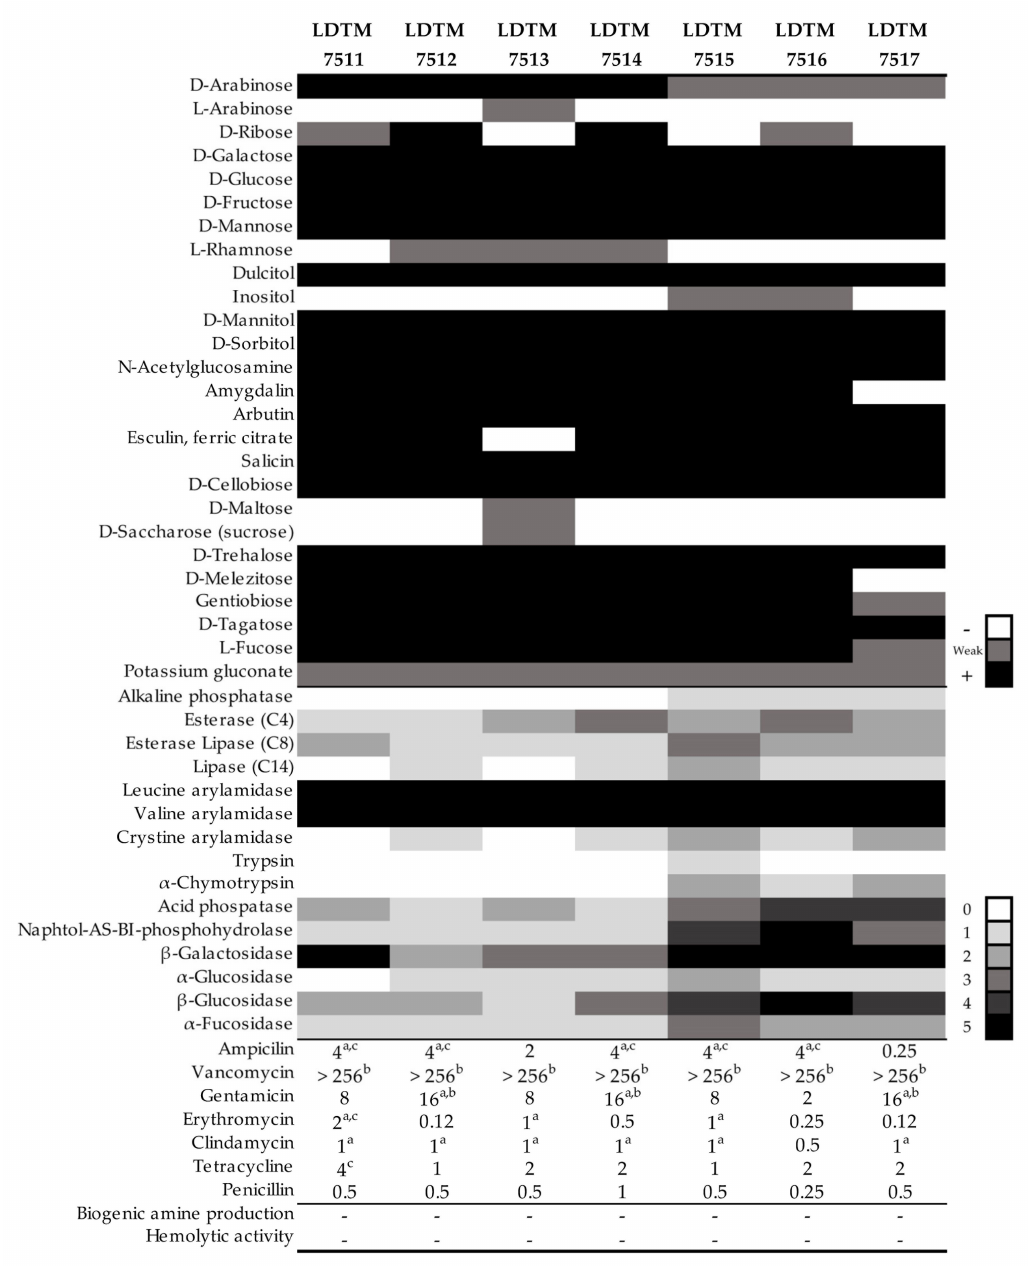
Figure 1. Fermentative / enzymatic profiles and safety assessment of isolated Lactobacillus rhamnosus strains. The legend on the right indicates the contrast intensity in each profile. No reaction in fermentative / enzymatic profiles was not indicated. Antibiotic resistance was determined based on the microbiological breakpoints suggested by EFSA (2012), CLSI (2010), and Danielsen and Wind (2003), and the minimum inhibitory concentration (MIC) values ( µ g / mL) above each criterion are indicated by superscripts of a, b, and c,